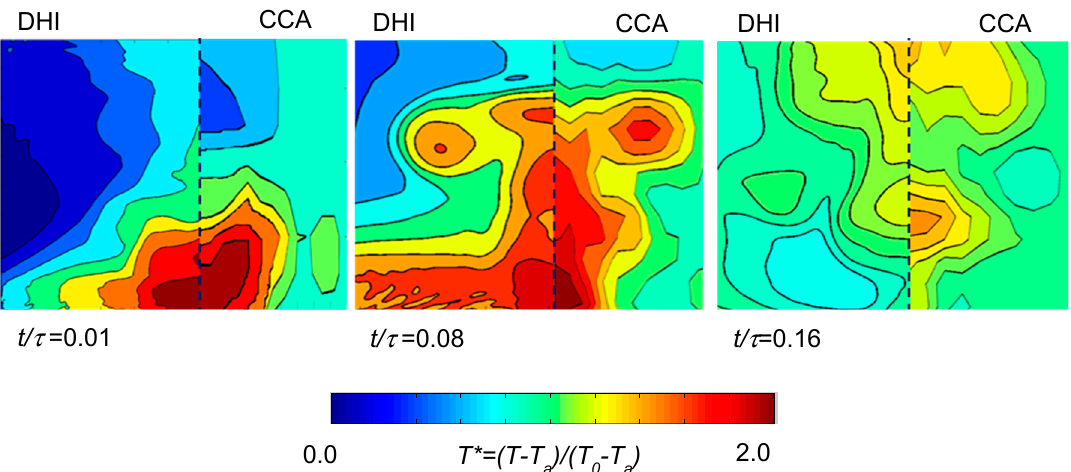
Figure 5. Temperature field of heated SJ over different t / τ . It has to be noted that the CCA is a point measurement, and that the probe was traversed in the plane x – y , i.e., z = 0, with a step of 1 mm. On the other hand, DHI allows for profile measurements in one moment, and profiles are obtained as mean values along the z -axis.